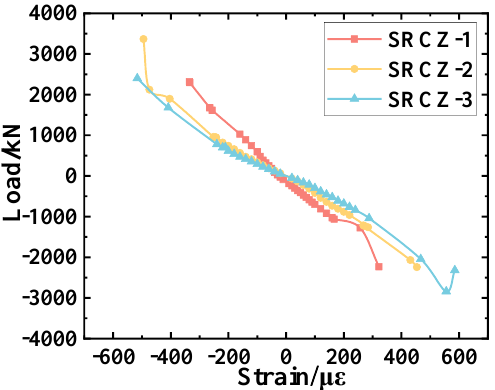
Figure 10. Load – Strain Curve of the Longitudinal Reinforcement.